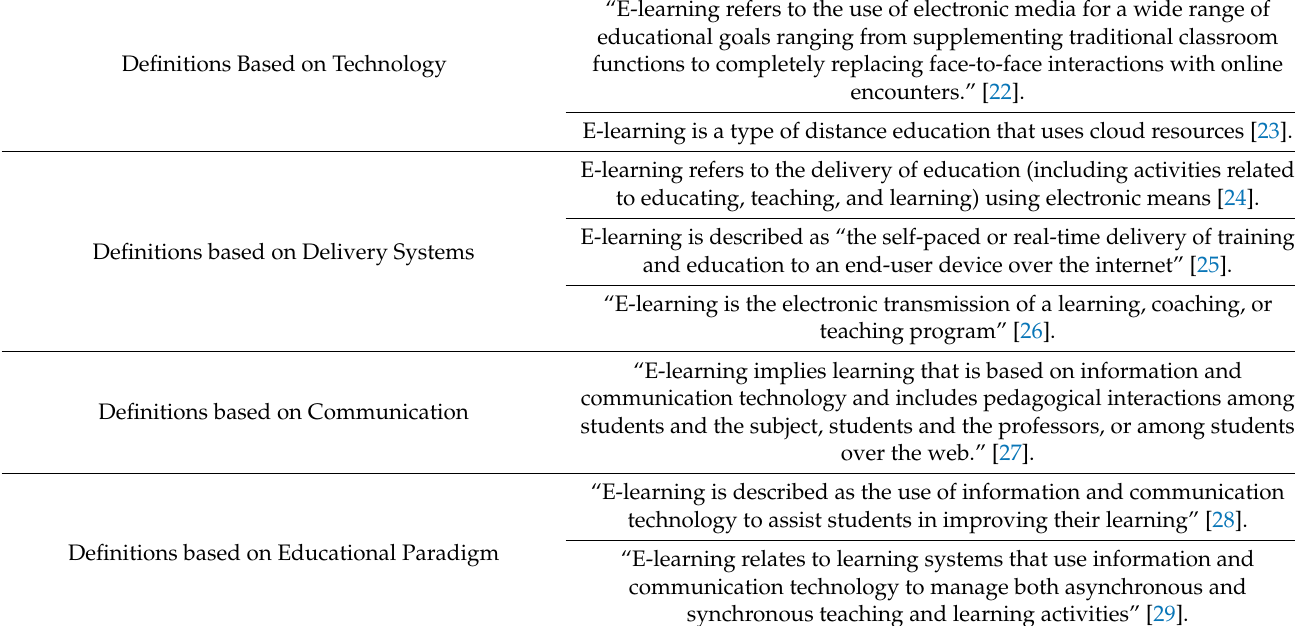
Table 1. Definitions of